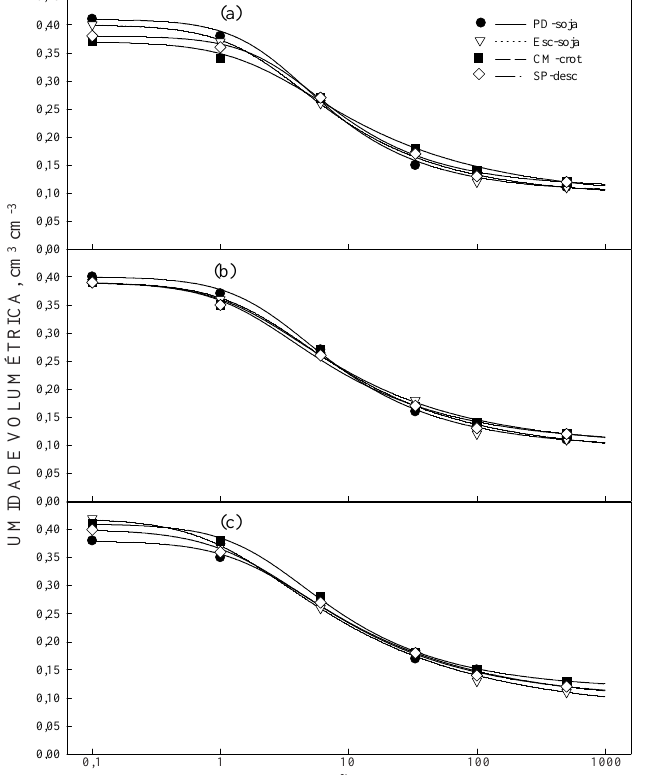
Figura 8. Curva característica de água no solo observada e calculada pela equação de Van Genuchten para as profundidade de 0,02 a 0,05 m (a), 0,12 to 0,15 m (b) e 0,35 a 0,38 m (c) em solo sob diferentes sistemas de manejo.